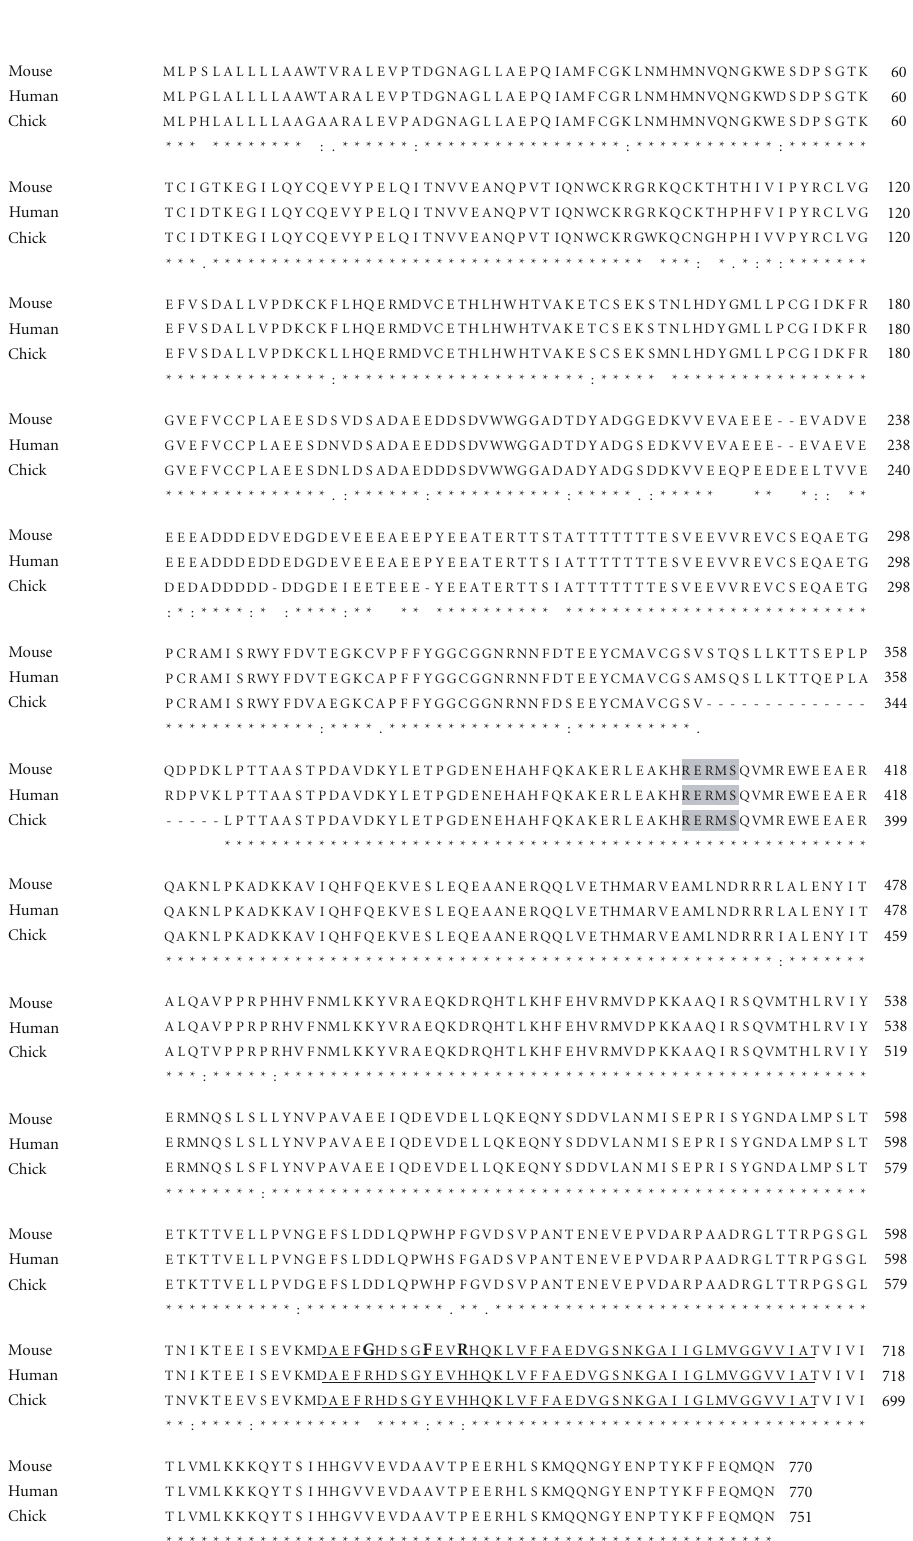
Figure 1: Alignment of the amino acid sequences of human, mouse, and chick APP. The numbering refers to the human APP sequence. The RERMS sequence is in gray. Amino acid sequences of A β domain are underlined. Residues implicated in amyloidogenesis are indicated in bold. The human (P05067), chicken (Q9DGJ7) and mouse (P12023) APP sequences were obtained from the EMBL database (CLUSTAL 2.0.12 multiple sequence